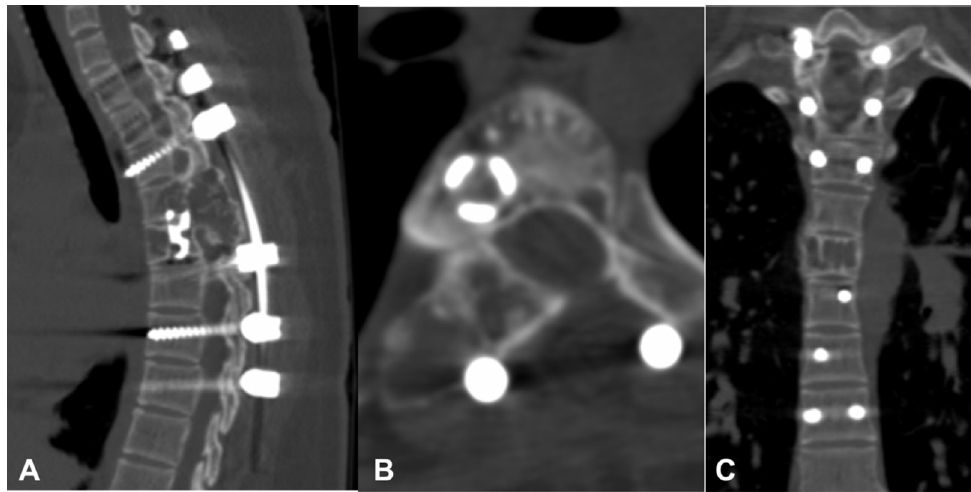
Figure 7. 2-year follow-up CT scan. Ossi fi cation of the lesion with remodelling of the spinal canal and incorporation of Harm's cage seen on Sagittal (A), axial (B) and Coronal (C)